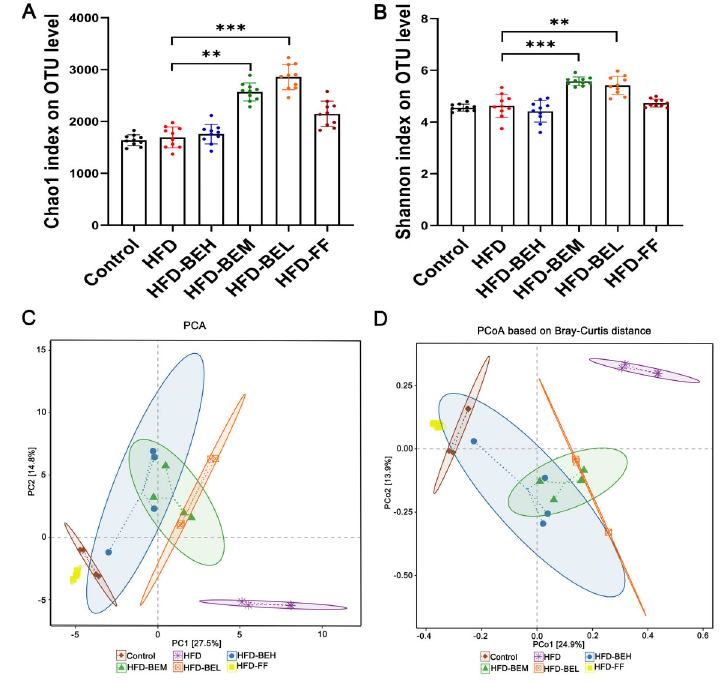
Figure 3. Effect of berberine and evodiamine (BE) at high, medium, and low doses (BEH, BEM, BEL) or feno fi brate (FF) on the diversity of gut microbiota of animals fed a high-fat diet (HFD). Alpha diversity analysis of Chao1 ( A ) and Shannon indexes ( B ) on operational taxonomic units (OTU). C , Beta diversity analysis, principal component analysis (PCA) plot and ( D ) principal co-ordinates analysis (PCoA) based on Bray-Curtis distances on OTU level. Data are reported as means ± SD. **P o 0.01, ***P o 0.001 (one-way